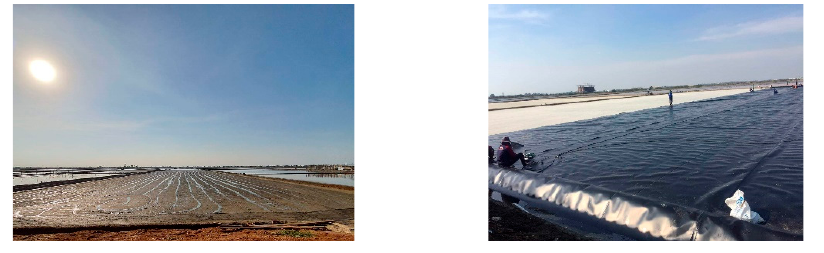
Figure 2. Traditional technology ( Left ) and HDPE-geomembrane-lined pond ( Right ).